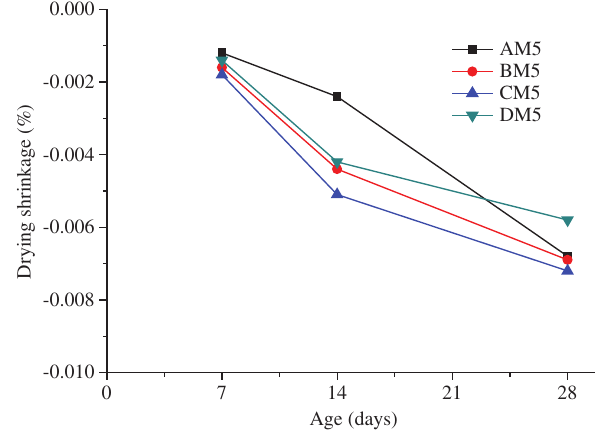
Figure 5: Drying shrinkage of AAFA geopolymer with the alkaline solution/binder ratio of 0.5 vs.